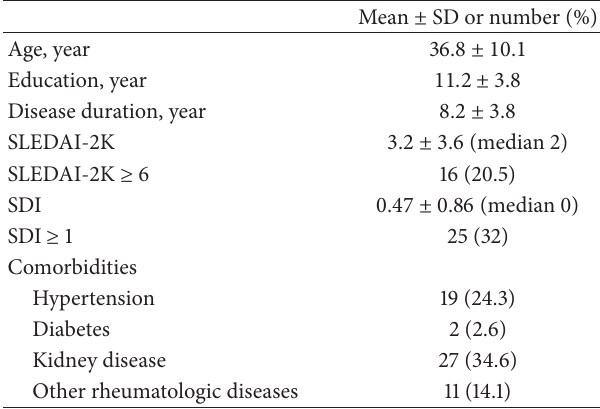
Table 1: Characteristics of the study participants ( 𝑛 = 78